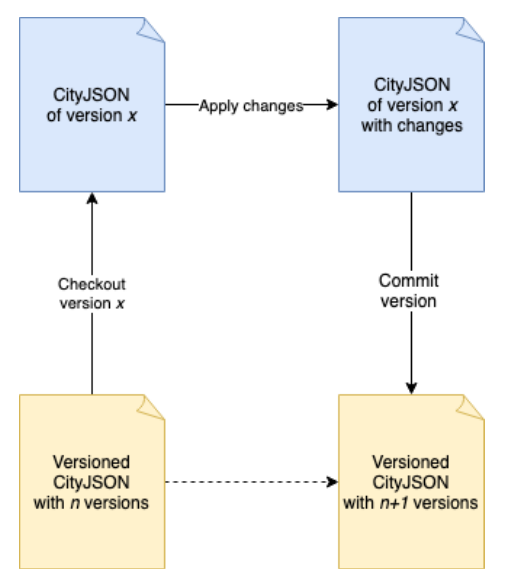
Figure 2. Proposed versioning for CityGML version 3, from OGC (2019).